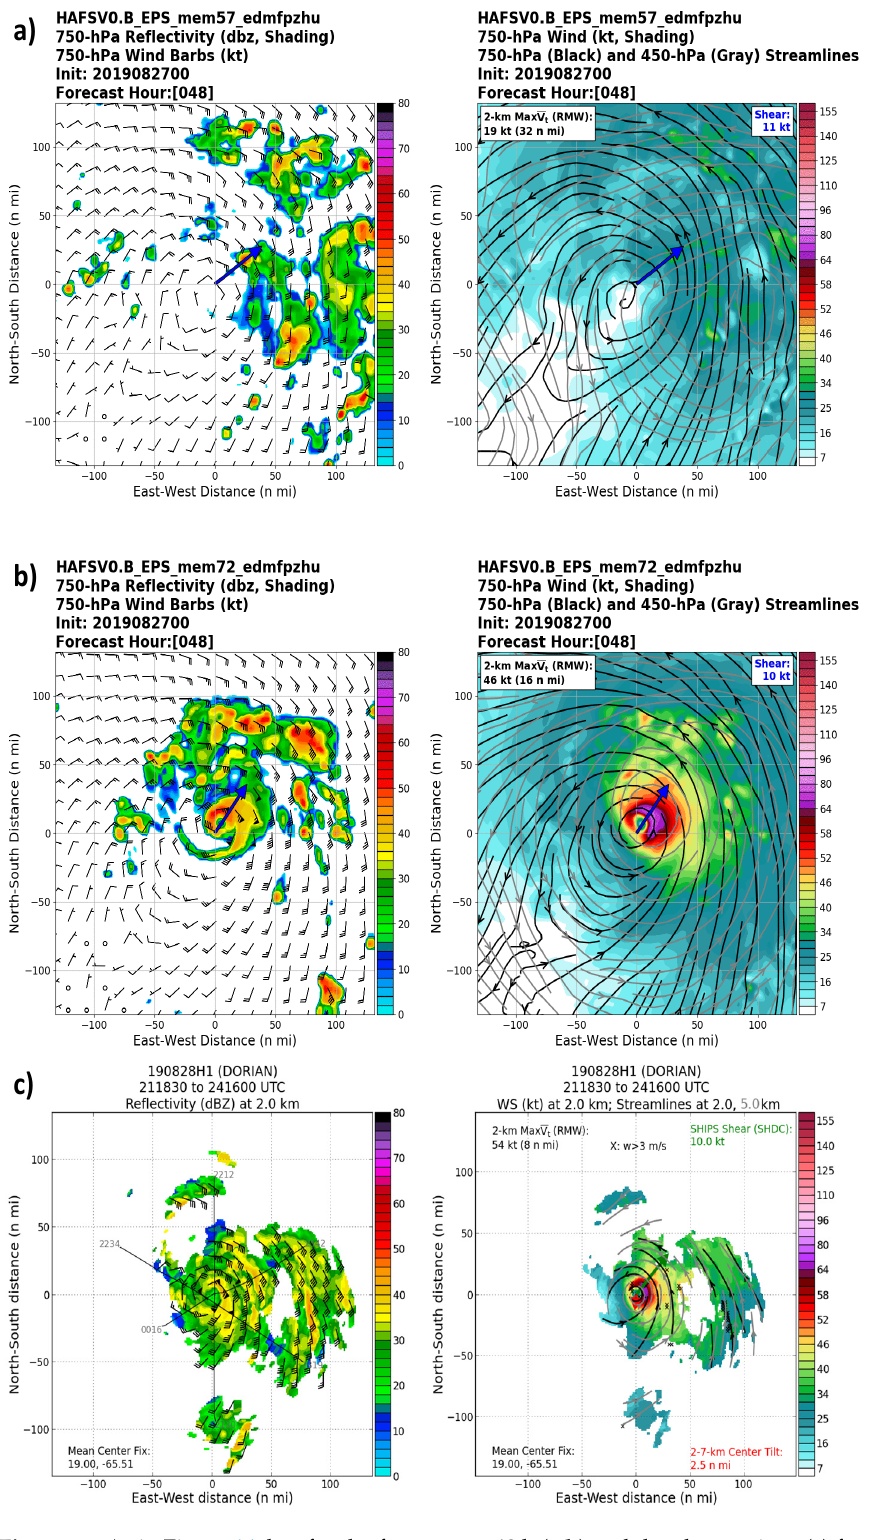
Figure 15. As in Figure 14, but for the forecasts at 48 h ( a,b ) and the observations ( c ) from the flight period from 2118 UTC 28 August 2019 to 0016 UTC 29 August 2019.